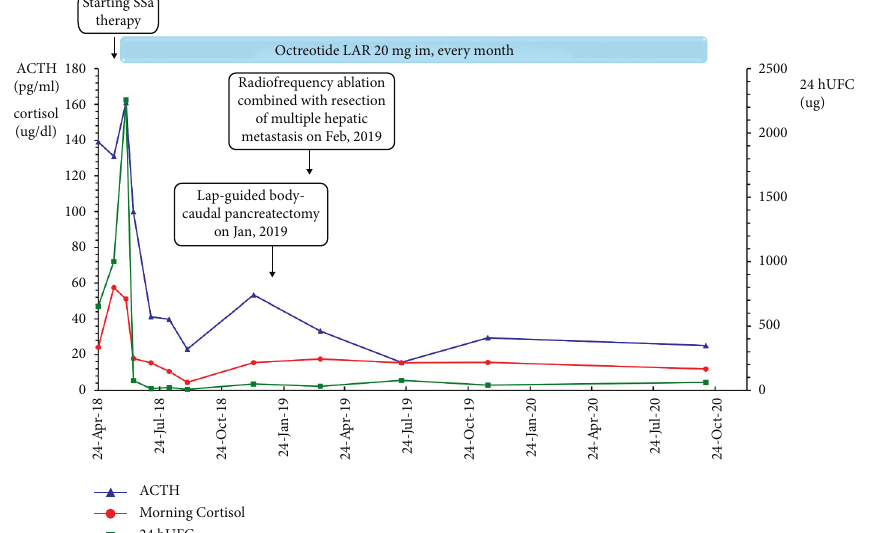
Figure 3: ACTH, morning cortisol, and UFC trends during the follow-up after SSA treatment and surgery. Short-term (13 days) octreotide therapy prompted marked reductions in ACTH levels (from 131 to 63pg/mL) and cortisol levels (from 57.47 to 7.16 μ g/dL), and UFC levels decreased to the normal range (55 μ g per day). Surgery and long-term octreotide LAR therapy maintained the hormones normally, with ACTH fluctuating from 23.0 to 53.4ng/L and UFC fluctuating from 6.96 to 48.84 μ g/24